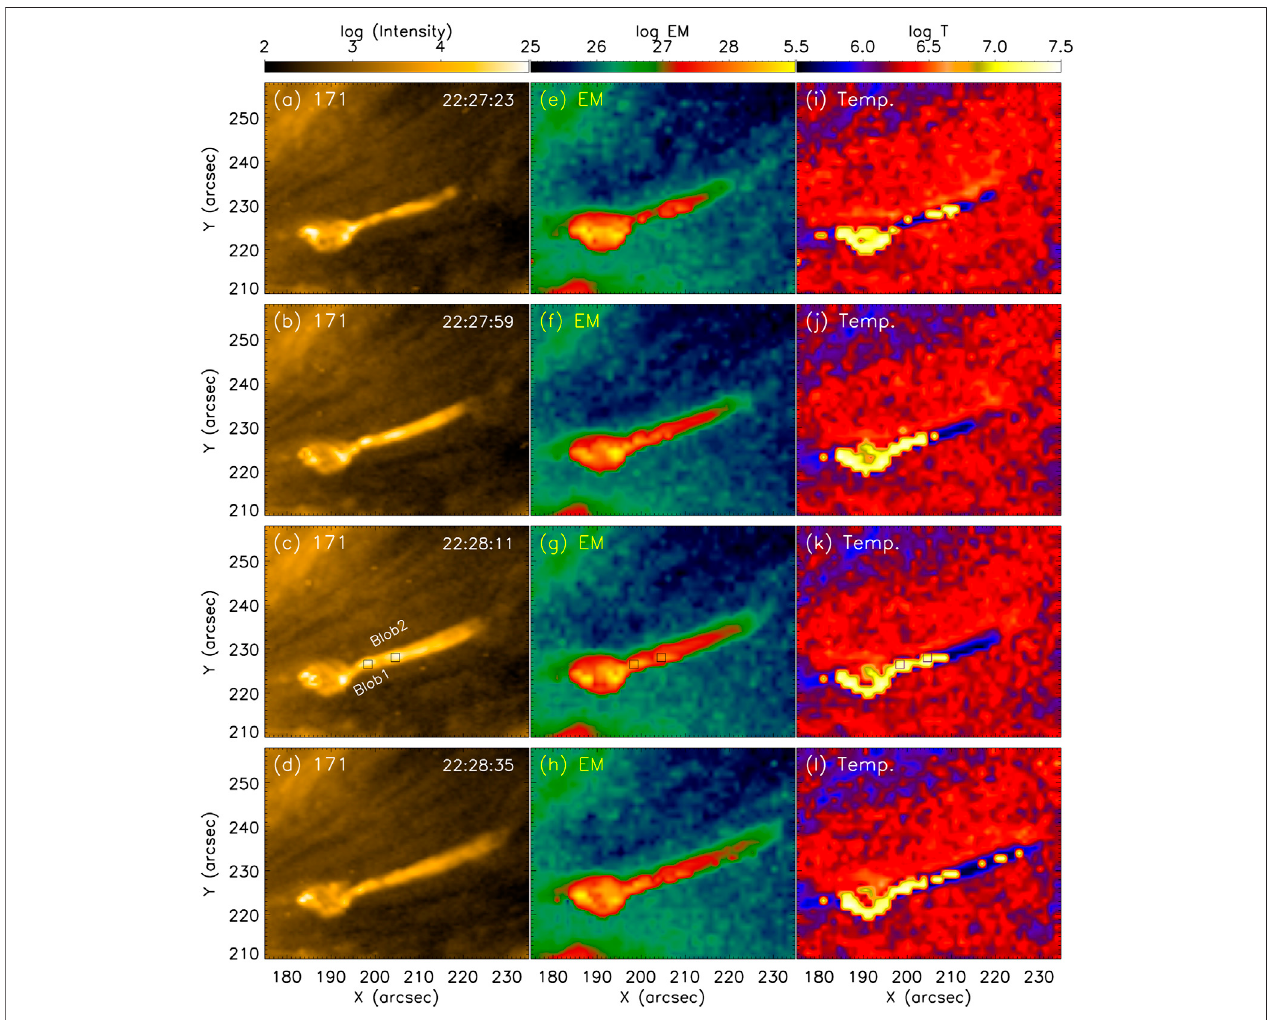
FIGURE4| Column1:evolutionofthejetinPhase1withtheblobformationin171 Å atthreeconsecutivesnapshotswithtimeindicatedintheupperrightcornerin each panel. Column 2:emission measureofthejet atthesametime asindicated incolumn1. Column 3:DEM-weightedaveragetemperatureofthe jetat thetimes asof column 1. FOV: 60 ′′ × 48 ′′